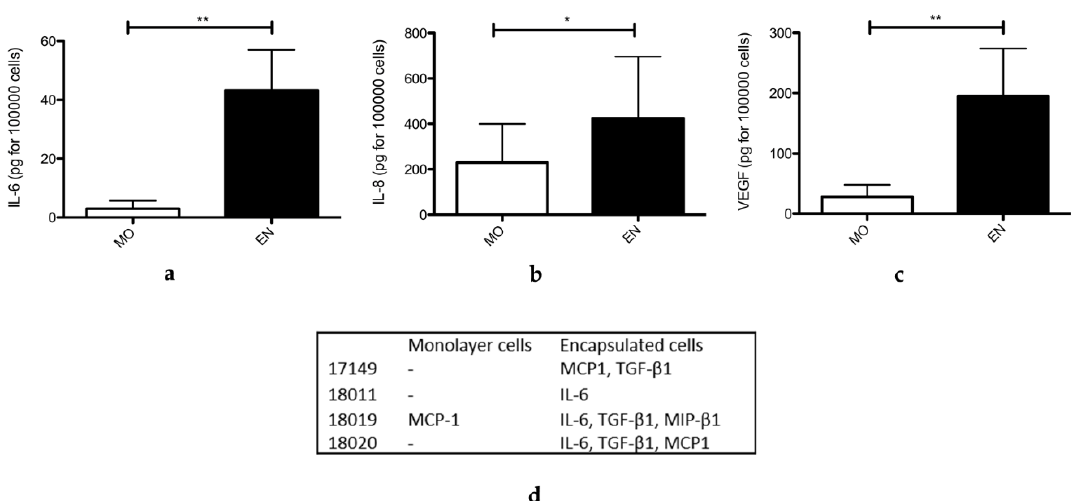
Figure 6. Secretome of encapsulated and monolayer ASC cultures detected by quantitative ELISA in supernatants sampled after 48 h culture in serum-free medium for donors 16,023 at P3 and P4, 16,148, 18,011, 18,019, 18,020, 16,198, and 17,149 at P3, n = 8 ( a – c ). Cells were grown as monolayers (MO) or were encapsulated (EN). Statistical significance of unpaired comparisons was assessed with the Mann and Whitney test. *: p < 0.05; **: p < 0.01 ( a ) Concentrations of cytokine IL-6 expressed in pg for 100,000 cells obtained for monolayer cells and encapsulated cells. ( b ) Concentrations of cytokine IL-8 expressed in pg for 100,000 cells obtained for monolayer cells and encapsulated cells. ( c ) Concentrations of VEGF expressed in pg for 100,000 cells obtained for monolayer cells and encapsulated cells. ( d ) Cytokines detected by qualitative ELISA in supernatants sampled after 48 h culture in serum-free medium for four donors (17,149, 18,011, 18,019, and 18,020 at P3, n = 4). Cells were grown as monolayers or were encapsulated.